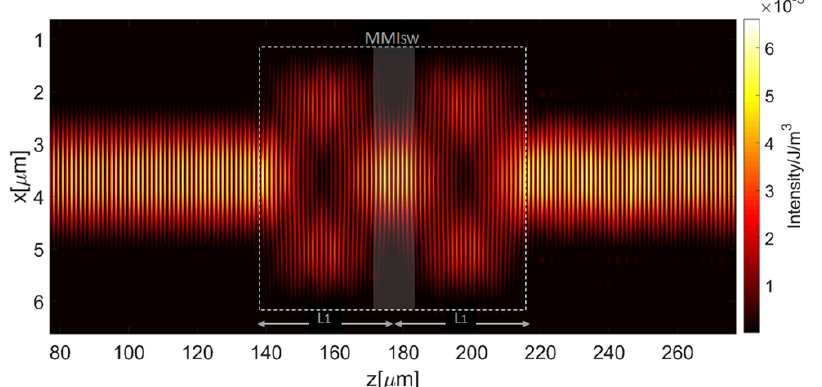
Figure 6. The interference pattern created by multimode interference effect in the MMI SW . Dotted line indicates the waveguide wall of the MMI SW .